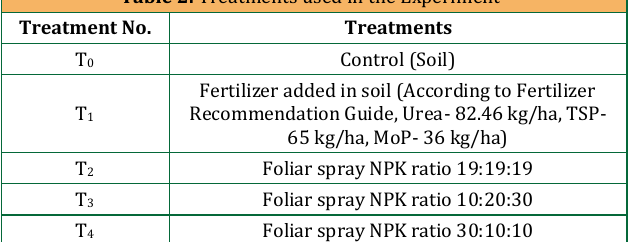
Table 2: Treatments used in the Experiment- Treatment